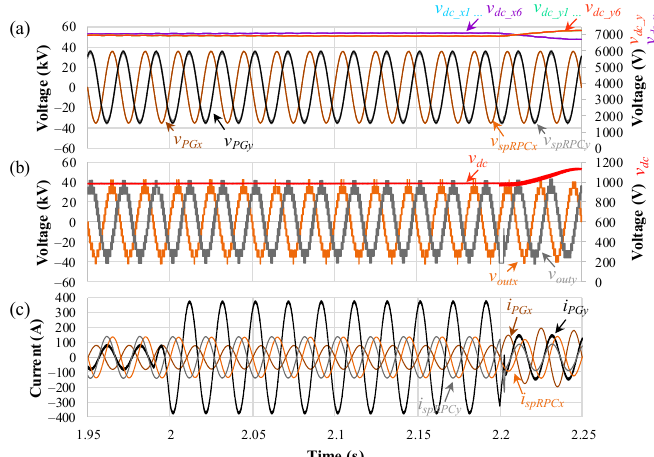
Figure 16. Detailed real-scale simulation results during the time interval from 1.95 s to 2.25 s: ( a ) the voltages on each TPS, v PGx and v PGy , the output voltages of the sp RPCx and sp RPCy , v spRPCx and v spRPCy , and voltages on the dc-link of each submodule, v dc_x1 to v dc_x6 , and v dc_y1 to v dc_y6 ; ( b ) the multilevel voltage of the spRPCx and spRPCy , v outx and v outy , and the voltage of the common dc-link voltage, v dc ; ( c ) the currents on each TPS, i PGx and i PGy , and the output currents of the sp-RPC, i spRPCx and i spRPCy .